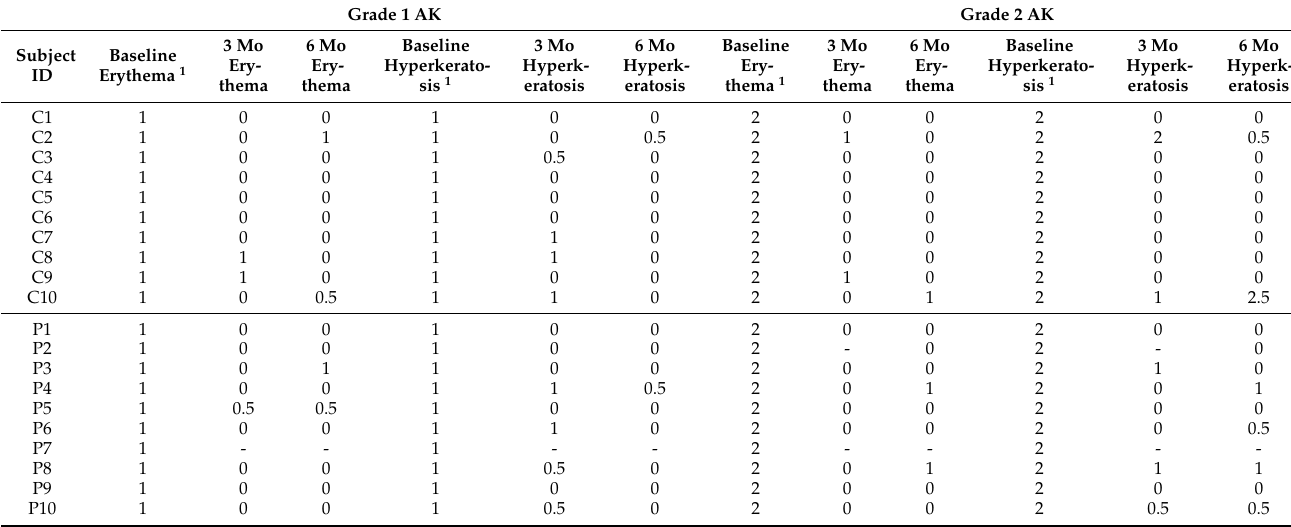
Table 1. Clinical scoring based on measures of erythema and hyperkeratosis, with green indicating complete response at 6 months, orange indicating partial response at 6 months, and pink indicating clinical